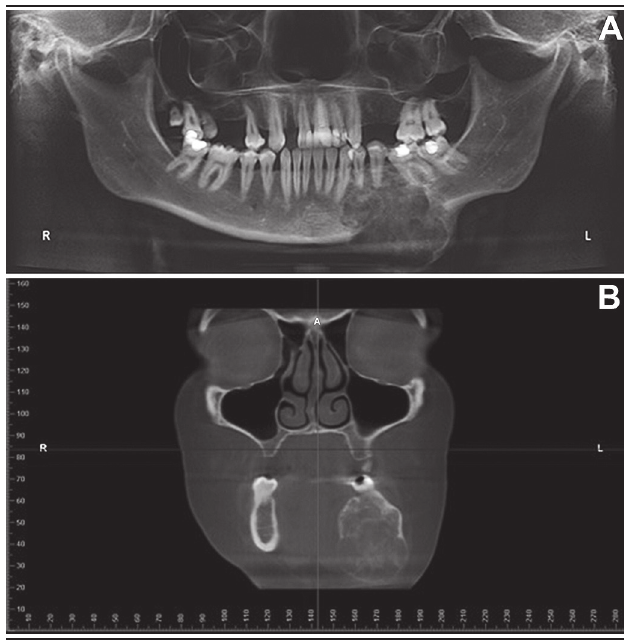
figurE 2 − Preoperative imaging A) panoramic radiograph showing a multilocular radiolucent image in the left mandibular body region, involving teeth 34, 35 and 36 with discrete root resorption; B) CT, coronal section, showing hypodense lesion expanding the cortical bone. CT: computed tomography.